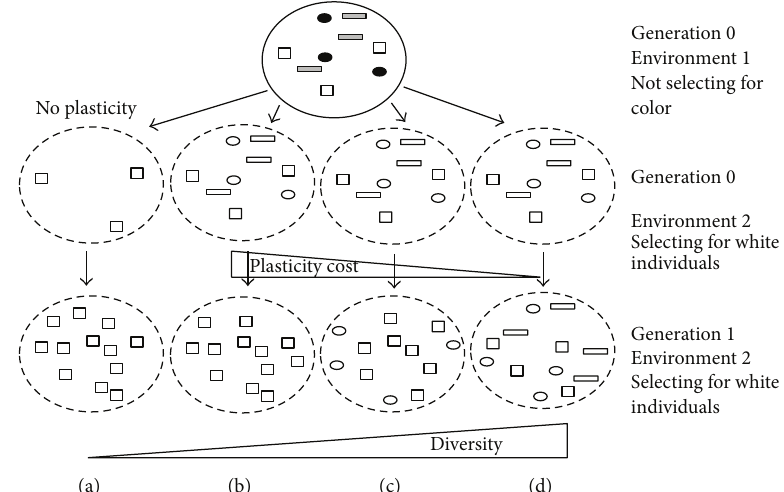
Figure 1: Impact of selection and plasticity on genetic diversity according to the cost of plasticity. Different forms represent genetic diversity and different colours represent different phenotypes and the population size is kept constant. (a) Without plasticity: strong decline of genetic diversity; (b) with equal plasticity among genotypes and a very strong cost of plasticity: strong decline of genetic diversity; (c) with equal plasticity among genotypes and a medium cost of plasticity for the circles and strong cost for the rectangles: low decline of genetic diversity; (d) with equal plasticity among genotypes and no cost of plasticity: maintenance of genetic